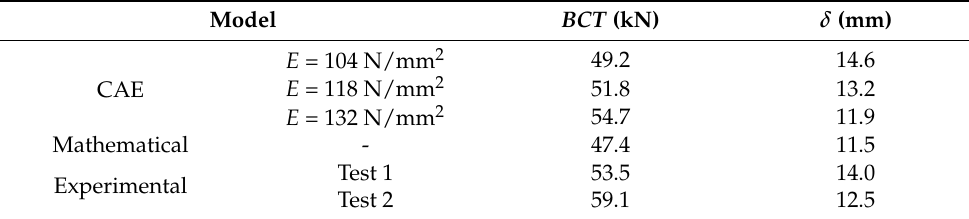
Table 6. Results of the BCT force and δ vertical displacement for experimental tests and for the CAE and mathematical models of the O-04.